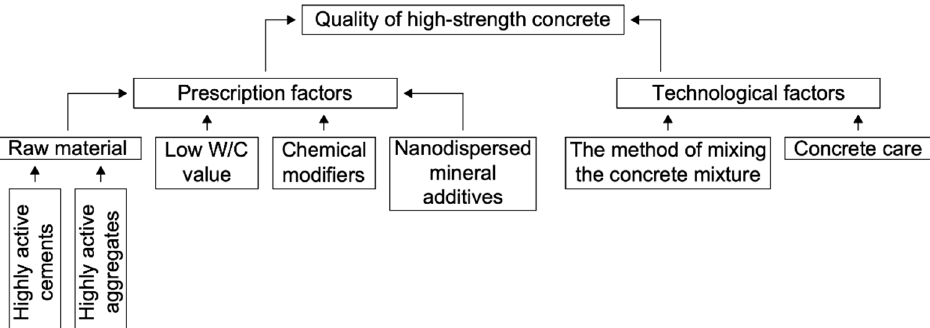
Figure 1. The main factors affecting the final value of the physical and mechanical characteristics of high-strength concrete.